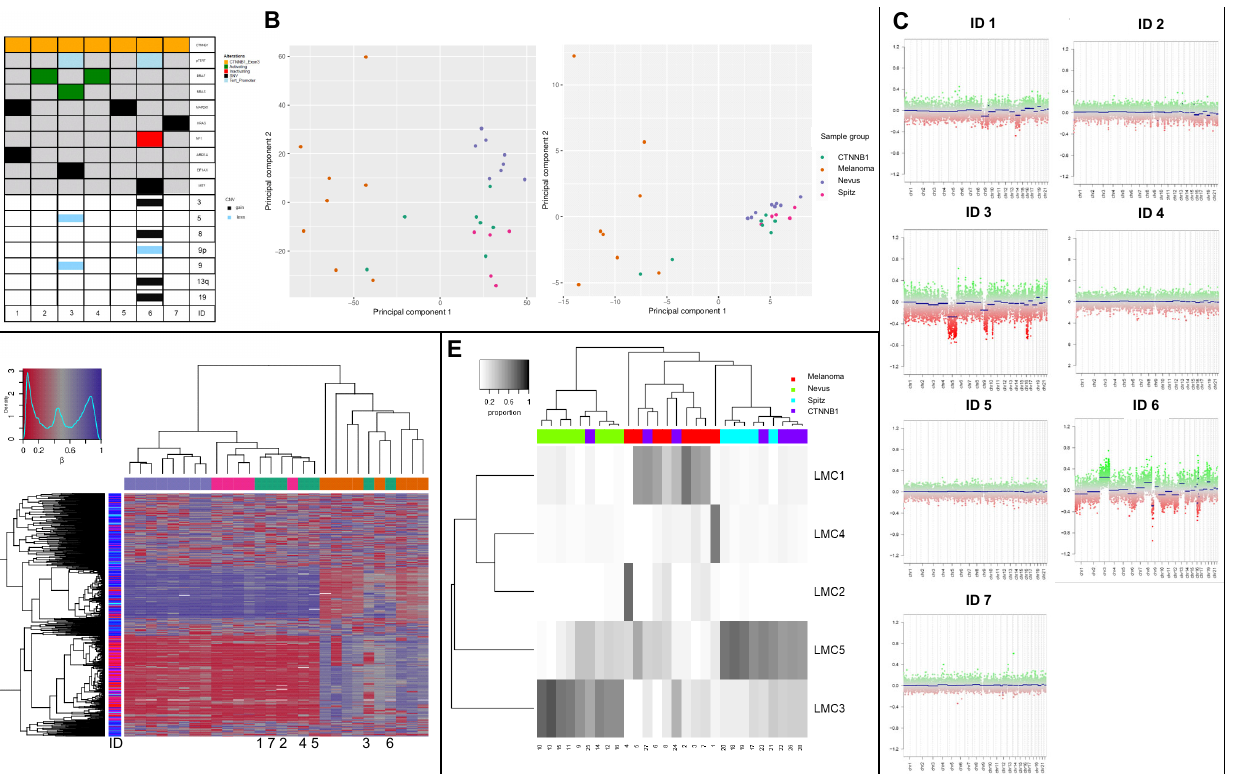
Figure 1. Oncoprint of all ( n = 7) unclassified melanocytic lesions including CNV profiles ( A ). Principal component analysis (PCA) of all subgroups for all sites and genes ( B ). Percentage of total variance was 43.0% for PCA 1 and 8.2% for PCA 2 or genes and 33.5% for PCA 1 and 9.1% for PCA2 for sites. Predicted CNV profiles from all seven patients with CTNNB1 ‐ mutation by ID. Heatmap showing average DNA methylation of 10,000 most differentially methylated sites. Hierarchical clustering is based on a correlation distance and complete linkage ( C ). Heatmap showing proportions of the LMCs in all patient samples (( D ), rows: n = 8 nevi, n = 8 malignant melanoma, n = 5 Spitz nevi, n = 7 CTNNB1 ‐ mutant melanocytic lesions) ( E ). Lambda values of 0.01 were used. LMC, latent methylation components.